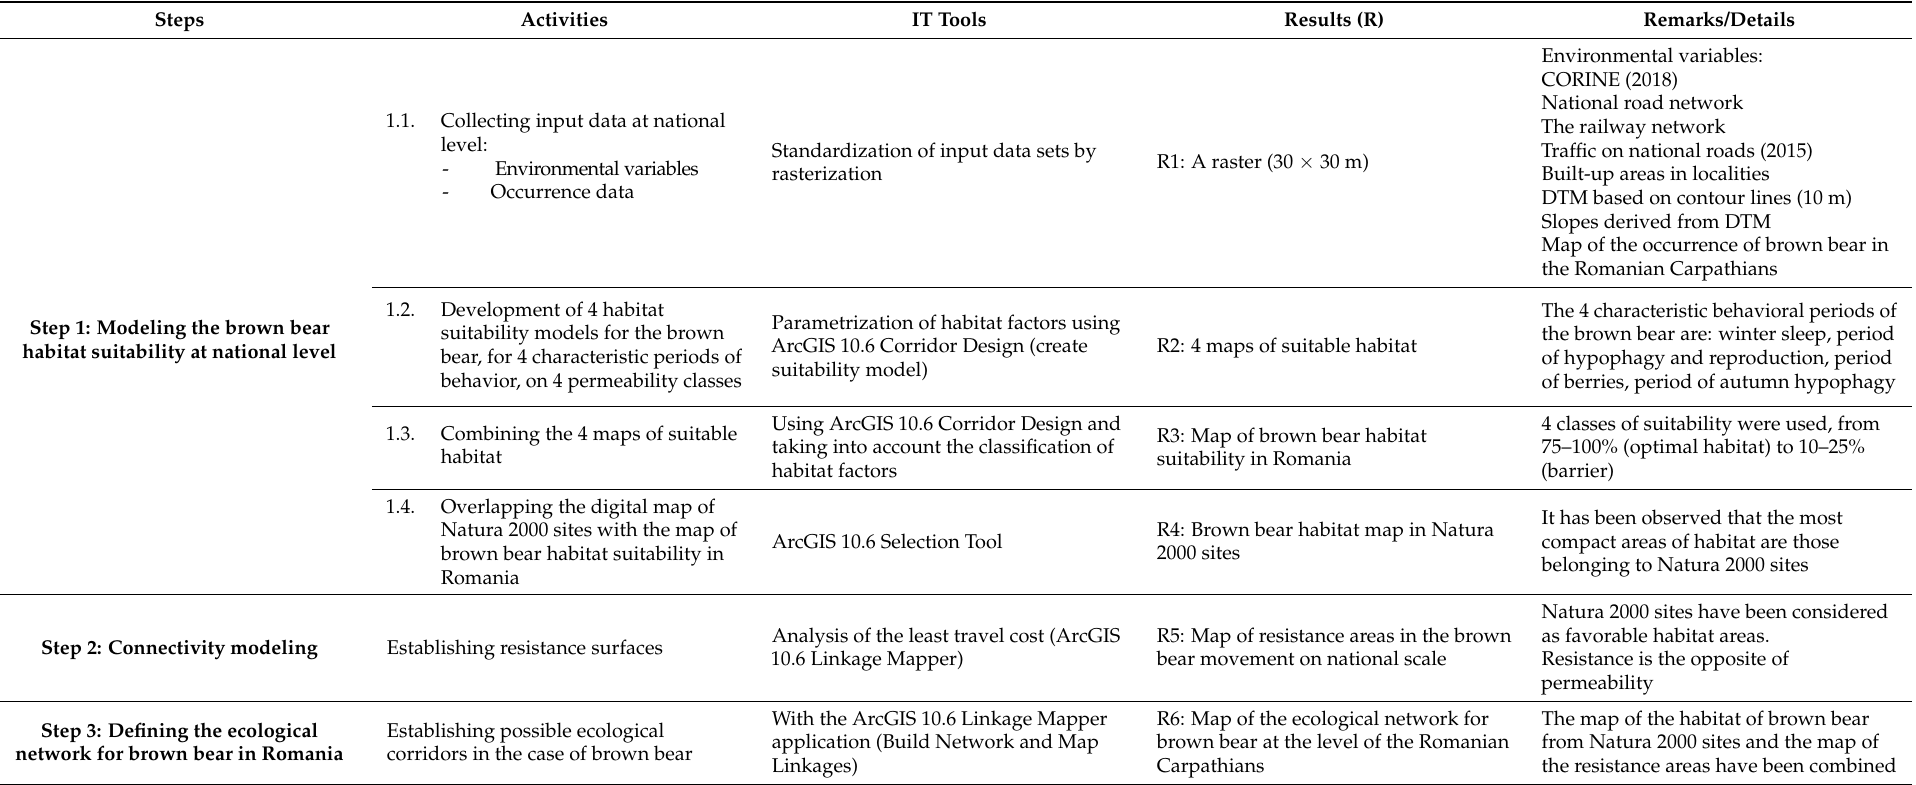
Table 2. Methodology: The three steps to identify ecological networks for the brown bear at national level. Each step is described in terms of sub-steps, activities, software and results. Habitat factors used as input data, intermediate and final results and maps are also